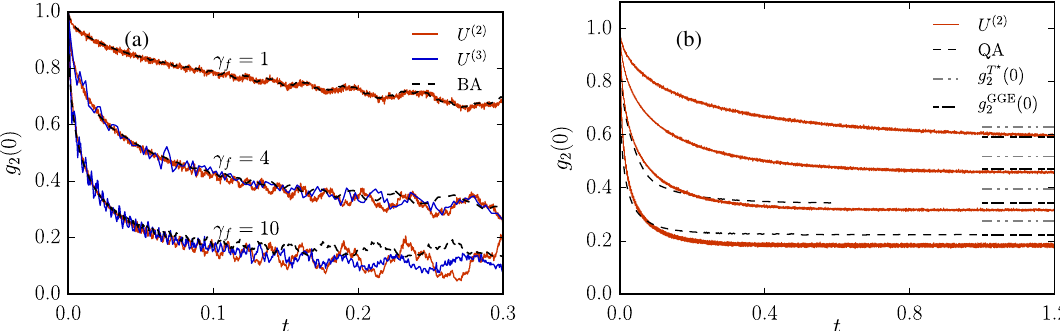
0 , i ¼ 1 , 2, 4, 8 (from top to bottom) compared to the quench f ¼